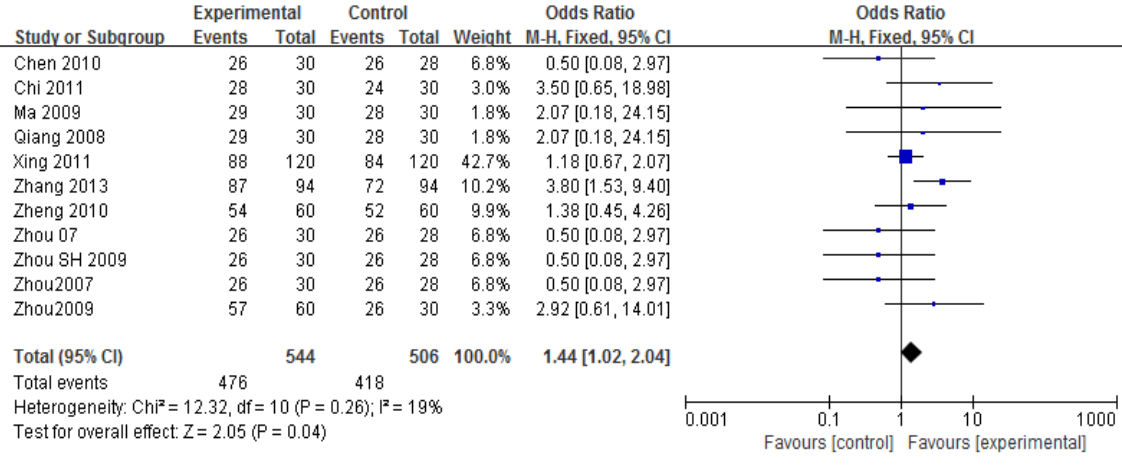
Figure 4: Meta-analysis of the studies evaluating effective rate of acupuncture